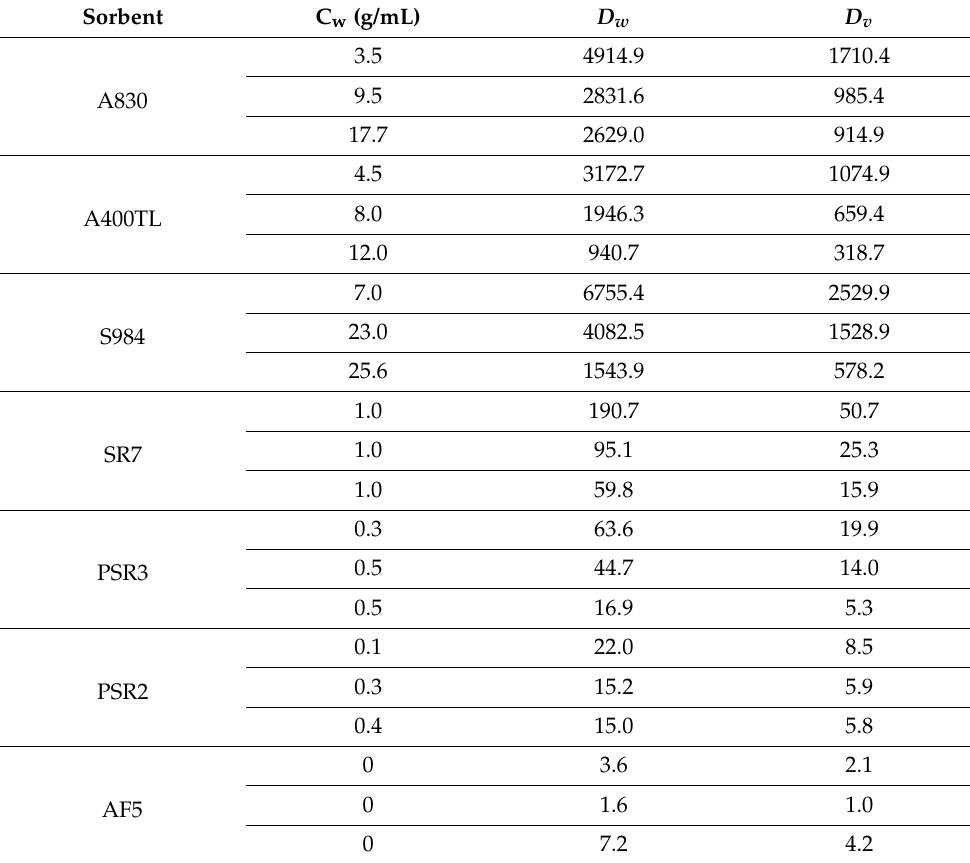
Table 7. Column parameters obtained for the vanadium adsorption from the solutions of the initial concentrations 50, 100, and 200